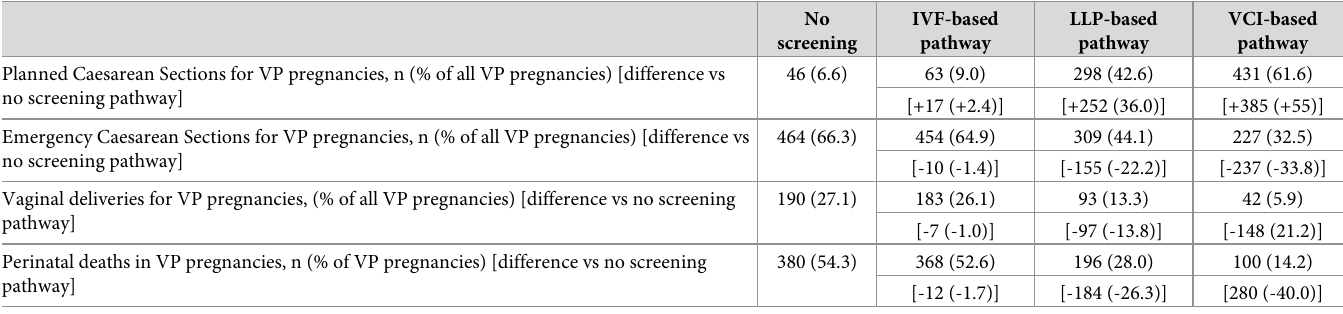
Table 4. Base case results for birth method and perinatal